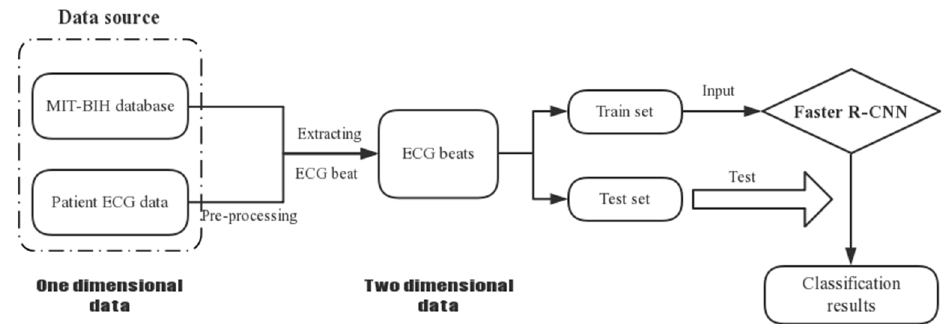
Figure 1. Overall procedure involved in electrocardiogram (ECG) beat classification.